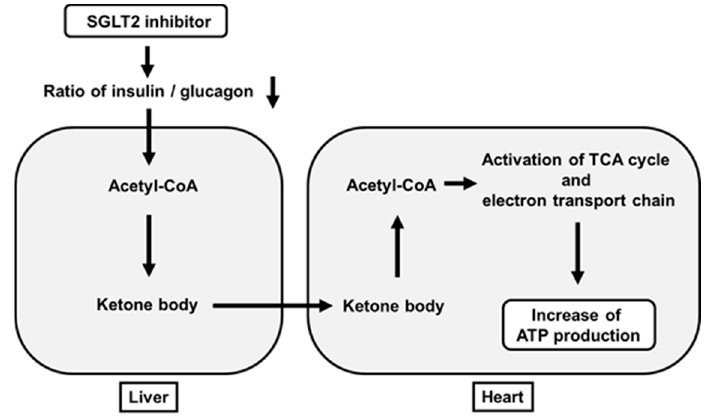
Figure 3. Favorable effects of SGLT2 inhibitors on ATP production in the heart beyond their glucose-lowering effect. SGLT2 inhibitors decrease a ratio of insulin to glucagon, which leads to increased ketone bodies (acetoacetate and β -hydroxybutyrate) in the liver. Such ketone bodies are carried to the heart. After this, they activate the TCA cycle and electron transporter chain in mitochondria and finally increase ATP production in the heart.